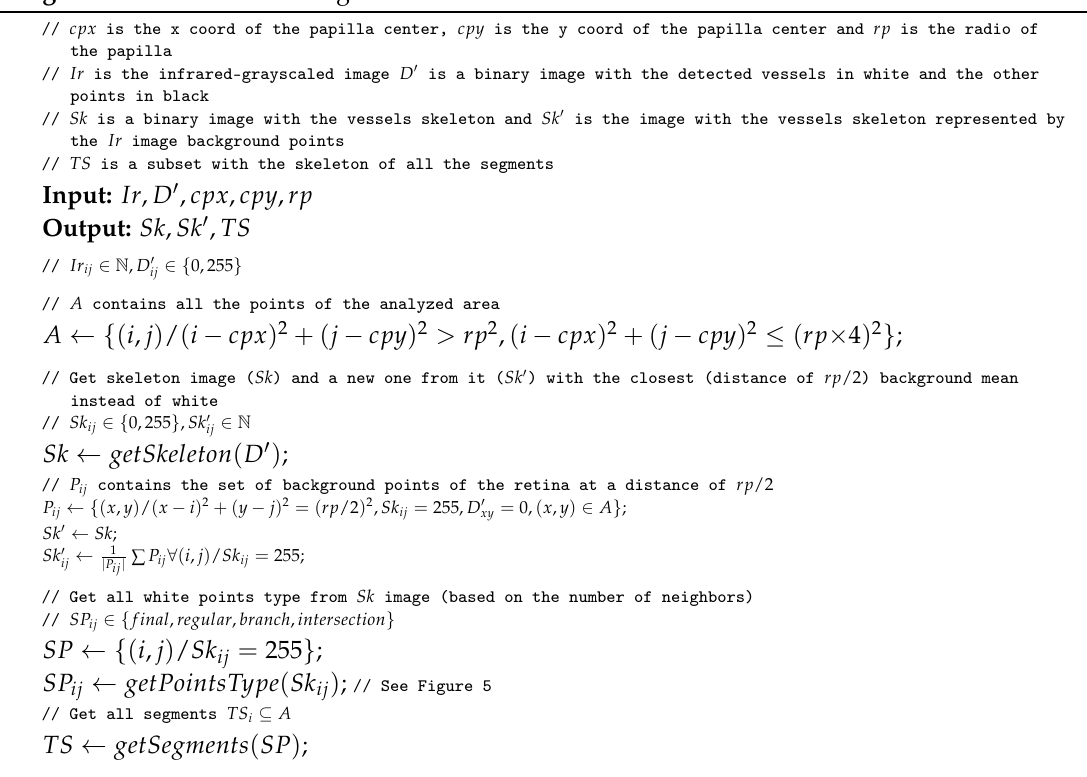
Algorithm 5: Skeleton and segment